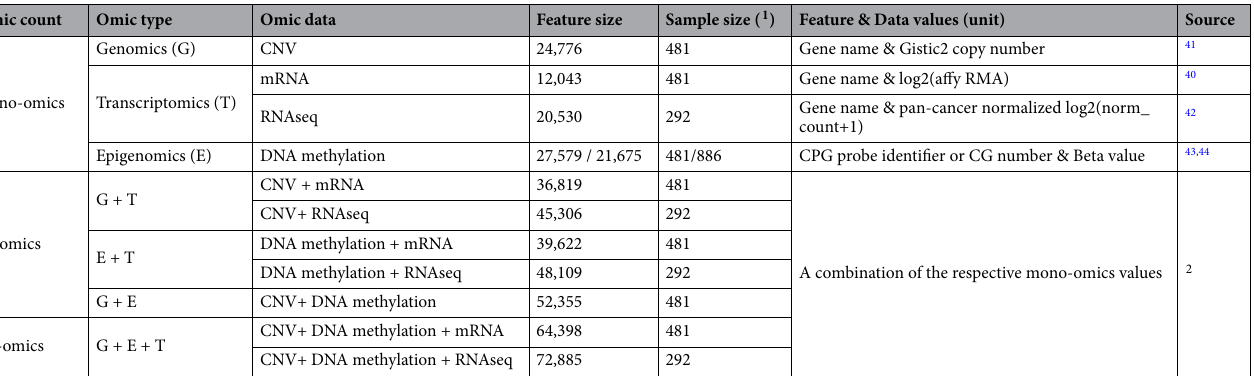
1 Sample size after intersection.